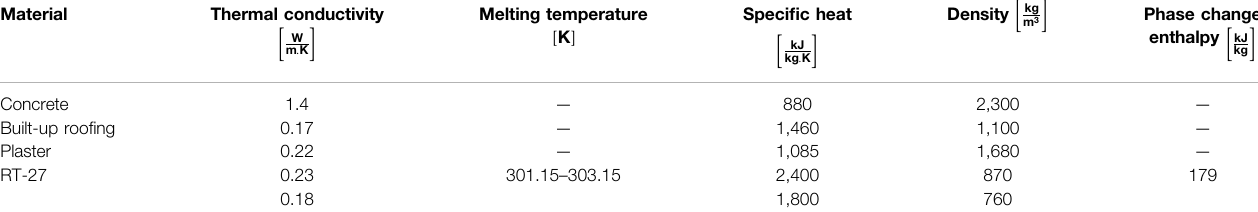
TABLE 1 | Properties of the construction materials and studied PCMs (ASHRAEAmerican Society of Heating and Engineers, 2016; Tian et al., 2020a). Material